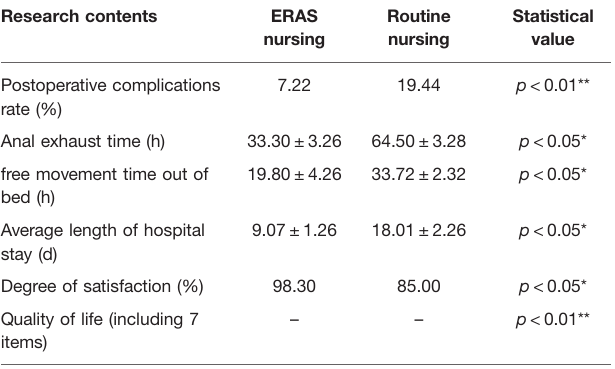
TABLE 1 | Statistical results of different research